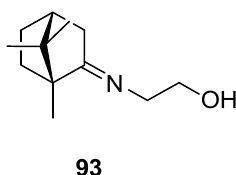
+ )-camphor and aminoethanol.